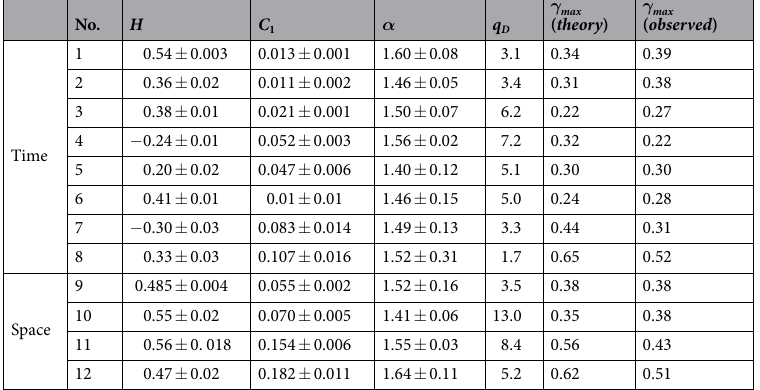
λ is the scale ratio: λ = (the length of the series)/(the resolution of the series) = the number of pixels; in Fig. 2a,b, λ = 360, 1000 respectively. The extreme spikes ( Δ Δ T T / ) in any 1000 point long series (e.g. Fig. 2b) have a proba- bility ≈ 1/1000. For Gaussian processes, the spikes with this probability are Δ Δ T T / = 4.12, this is shown by the solid lines in Fig. 2b, the line therefore corresponds to γ = Δ Δ λ ≈ . ≈ . T T log( / )/log log4 12/ log1000 0 20 . For comparison, Table 2 gives the both the observed maximum γ for each series in Fig. 2 as well as the generally comparable theoretically expected maxima for the multifractal processes with the parameters estimated for the series in question. In the general scaling case, the set of spikes that exceed a given threshold form a fractal set whose sparseness is quantified by the fractal codimension c ( γ ) = D − d ( γ ) where D is dimension of the space ( D = 1 for series and transects) and d ( γ ) is the corresponding fractal dimension. The codimension is fundamental since it is the expo- nent of the probability distribution:   Δ s log     − γ T c ( ) > λ s P s Pr ( ) ;   ≈ γ =  Δ λ T log (4) ( ) is the probability that a randomly chosen spike Δ Δ T T / exceeds a fixed threshold s, P ( s ) is a non- > Δ s Pr T Δ T scaling prefactor. c ( γ ) characterizes sparseness because it quantifies how the probabilities of spikes of different amplitudes change with resolution λ (for example when they are smoothed out by averaging). The larger c ( γ ), the sparser the set of spikes that exceed the threshold s = λ γ . A series is intermittent whenever it has spikes with c > 0. Gaussian series are not intermittent since c ( γ ) = 0 for all the spikes. To see this, note that for Gaussian pro- cesses the cumulative probability of a spike exceeding a fixed threshold s is independent of the resolution λ , Δ Δ > ≈ T T s P s Pr( / ) ( ) , where here, P ( s ) is related to the error function. Comparing this with Eq. 4, we see that c = 0. Equation 4 is true for scaling series of any scale ratio λ (i.e. any length, any resolution); its characterization in terms of γ and c ( γ ) is independent of λ , scale invariant. Scale invariance is in fact the physical symmetry princi- ple respected by the dynamics. Eq. 4 can be used to estimate the most extreme spike expected on a series with λ pixels. The probability of the corresponding singularity γ max is ≈ 1/ λ , hence from eq. 4, c ( γ max ) = 1 (equivalently, d ( γ max ) = 0) so that γ max can be estimated from the inverse codimension function: γ max = c − 1 (1); the far right col- umn of Table 2 shows that this provides reasonable estimates. Finally, we may note that c ( γ ) is not changed under certain transformations; for example under a linear change of variables. This means that although many of the analyses discussed here are proxy-based, as long as their calibration is linear, c ( γ ) and hence the intermittency will not be affected. In contrast, noise in the proxies (e.g. from bioturbation in ocean sediments, or isotope diffusion in ice cores) breaks the scaling at high frequencies; it will not affect the exponents estimated over the lower frequency scaling ranges. It is more difficult to generalize about the consequences of variable and uncertain chronologies, but at least in some cases - such as ice cores - the sampling intervals themselves can be highly variable – indeed spiky and scaling – yet at least in principle, the sampling intermittency may be statistically separated from the proxy intermittency (see box 11.3 in ref. 8 ).